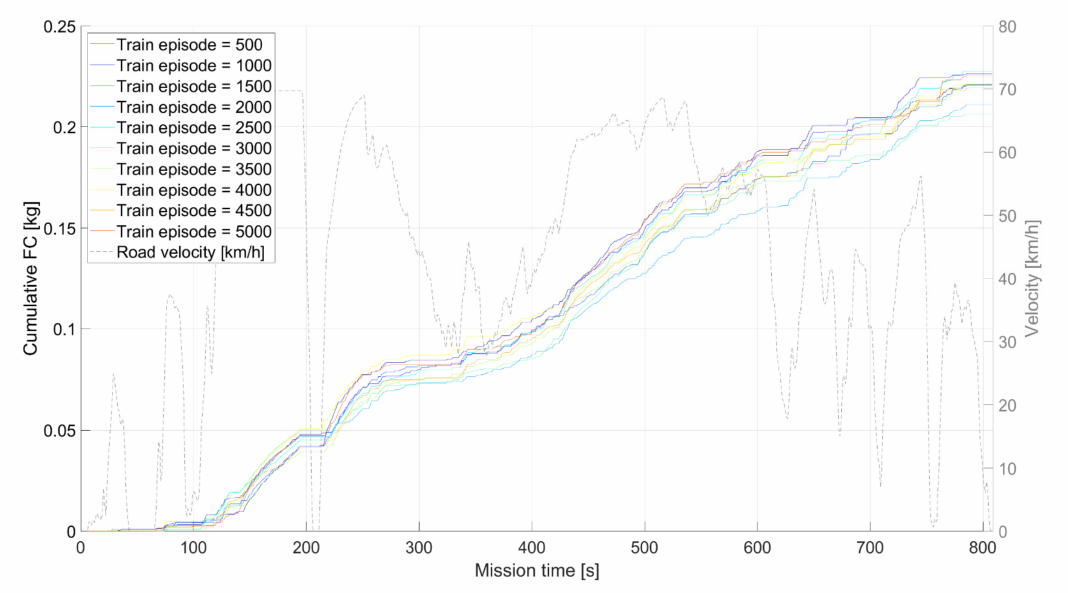
Figure 15. Cumulative FC over CLUST1 evaluated throughout several training episodes.